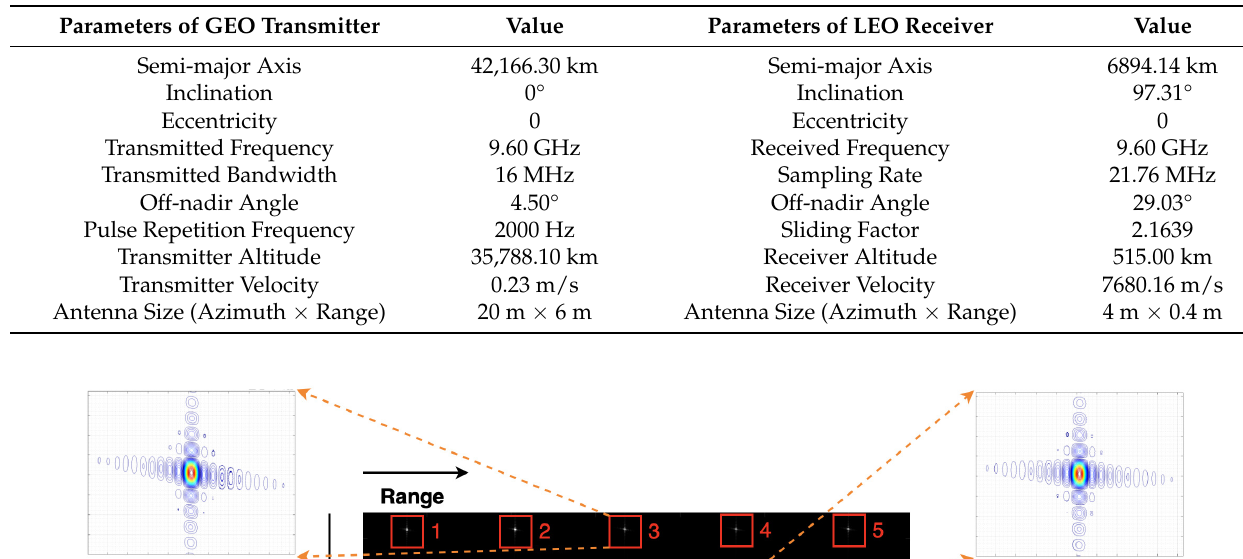
Figure 12. Comparison of imaging results obtained by convention NLCS method and the proposed method. ( a ) The imaging result of NLCS method, considering the azimuth perturbation generated by local fit method. ( b ) The imaging result of our proposed method. Table 3. Simulation experiment parameters of GTLR-BiSAR TOPS mode.